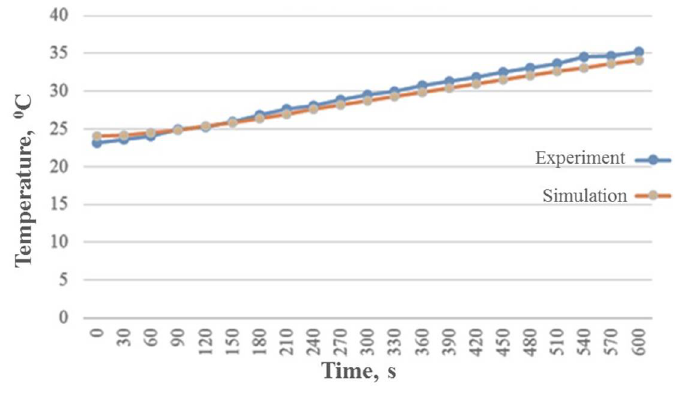
Figure 28. Temperature Measurement of double layer IPMSM.